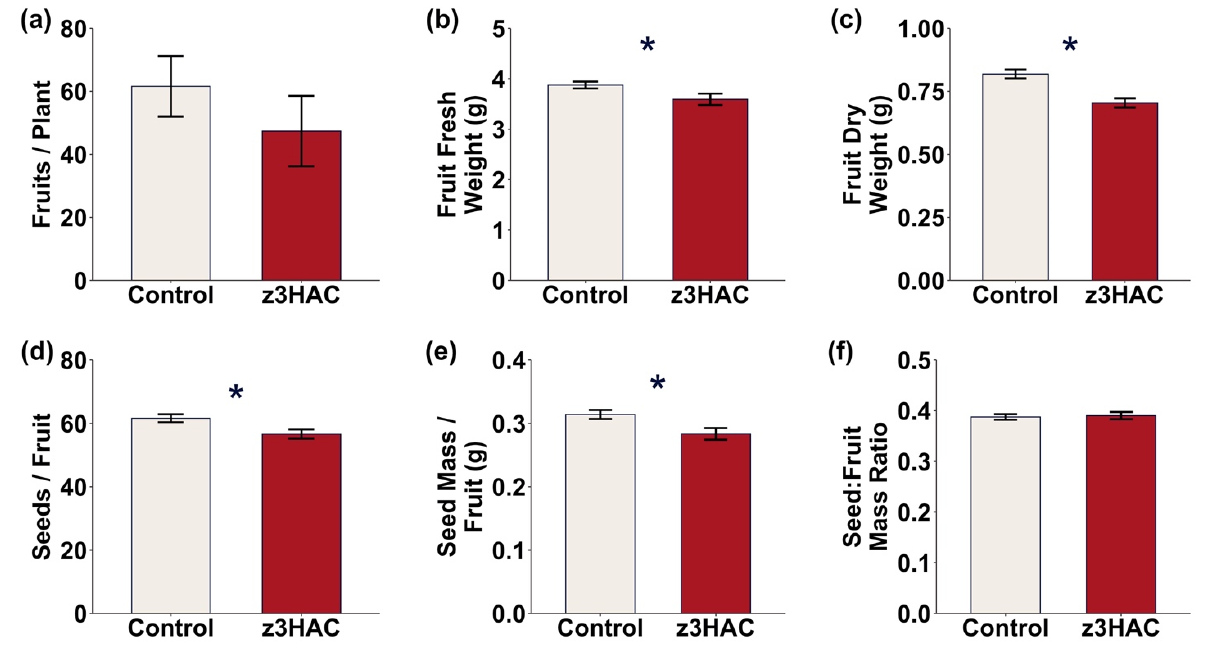
Figure 5. Fruit and seed production in Capsicum annuum (pepper) plants grown in a common garden experiment treated with a persistent application of the green leaf volatile cis -3-hexenyl acetate ( z 3HAC). The ( a ) total number of fruits were counted in the field, and ( b ) wet and ( c ) dry masses fruit masses were determined in the lab. ( d ) The total number of seeds per fruit and ( e ) the estimated mass per seed were determined from a subset of the fruits produced. ( f ) The ratio of seed mass to fruit mass was calculated to assess the efficiency of seed production. Bars represent the means +/ − S.E.M. Grey bars represent control plants; red bars represent plants treated with z 3HAC. Asterisks (*) represent p < 0.05 between treatment and control. See Supplemental Table S4 for statistics.